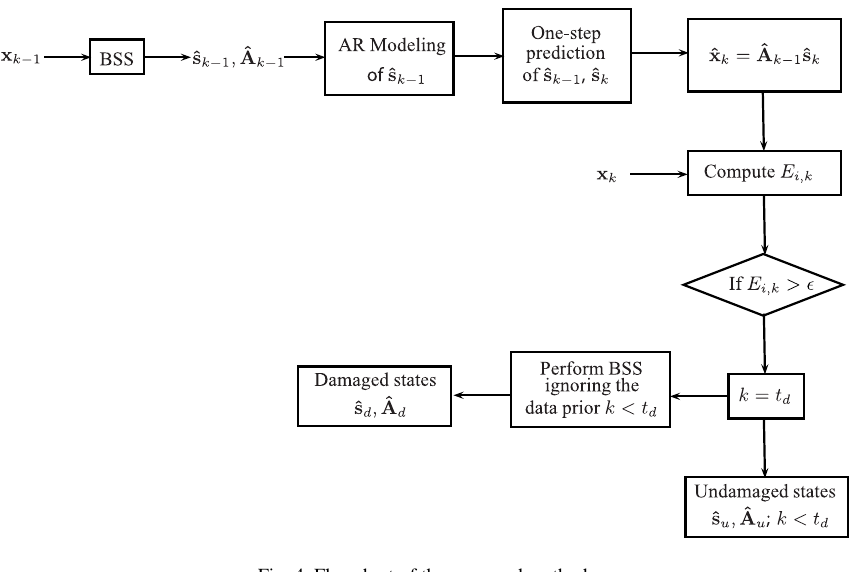
Fig. 4. Flowchart of the proposed